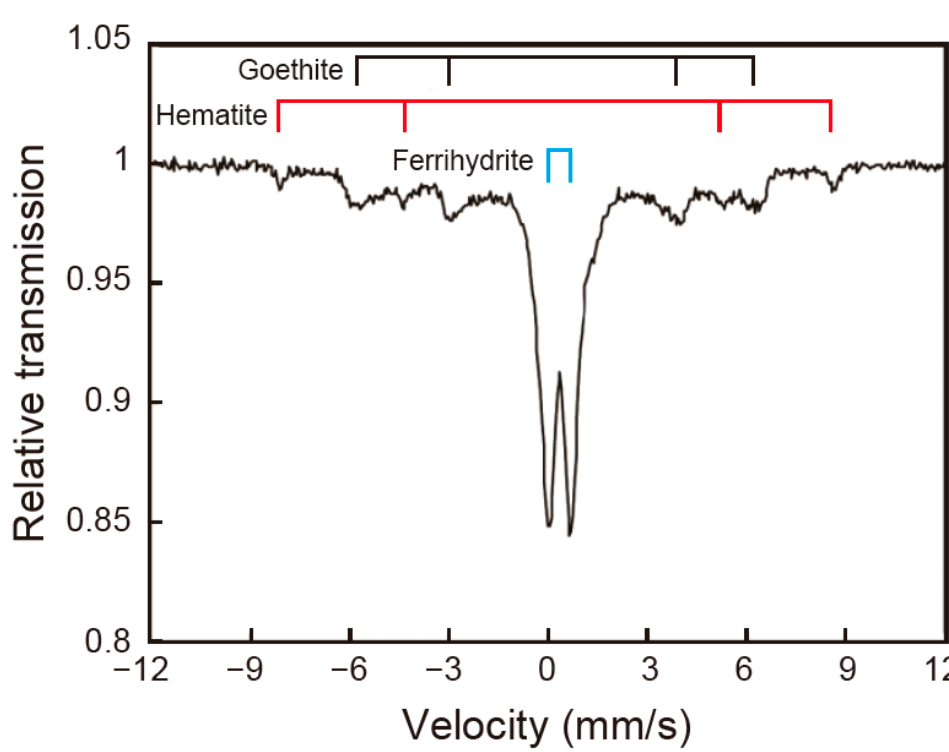
Figure 5. Mössbauer spectrum of the solid sample recovered from run 3 with peaks attributed to goethite (black line), hematite (red line), and ferrihydrite (blue line).